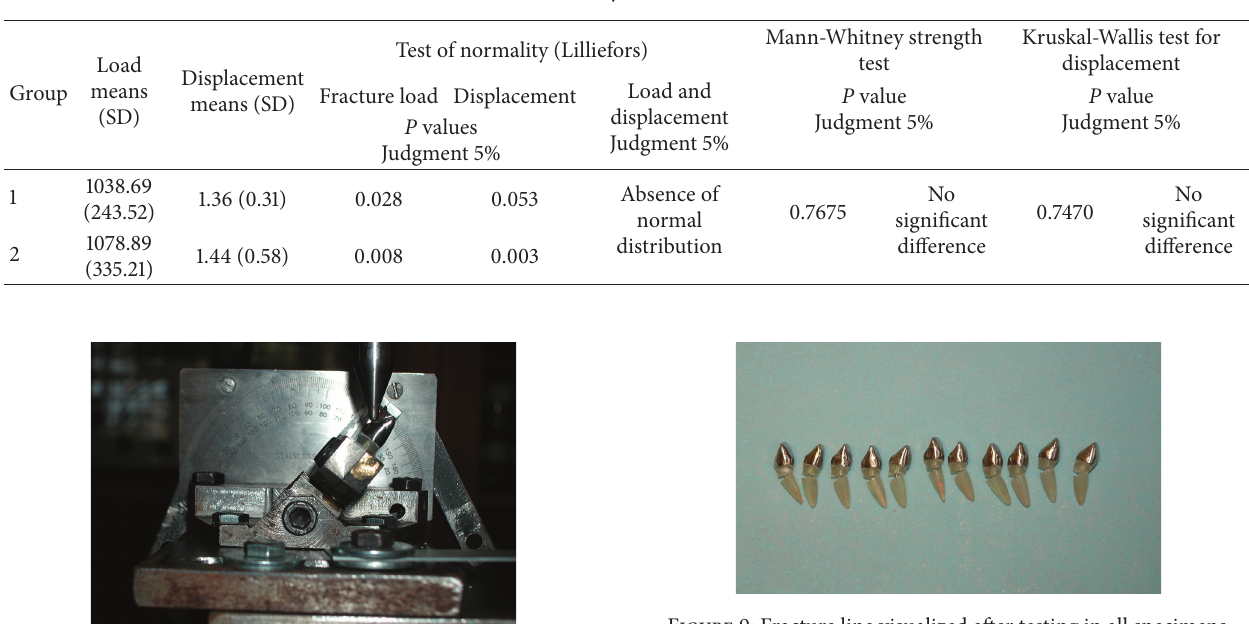
Table 1: Summary of statistical results.